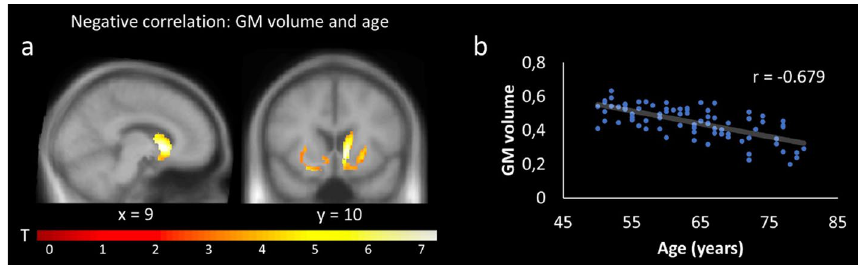
Figure 2. Negative relationship between age and GM volume. ( a ) SPM showing a significant negative relationship between GM volume and age within the right caudate, pallidum, and putamen; ( b ) showing the corresponding correlation plot for the cluster. For display purposes, SPMs were thresholded at p < 0.001, uncorrected, and superimposed on the mean T1-weighted image.